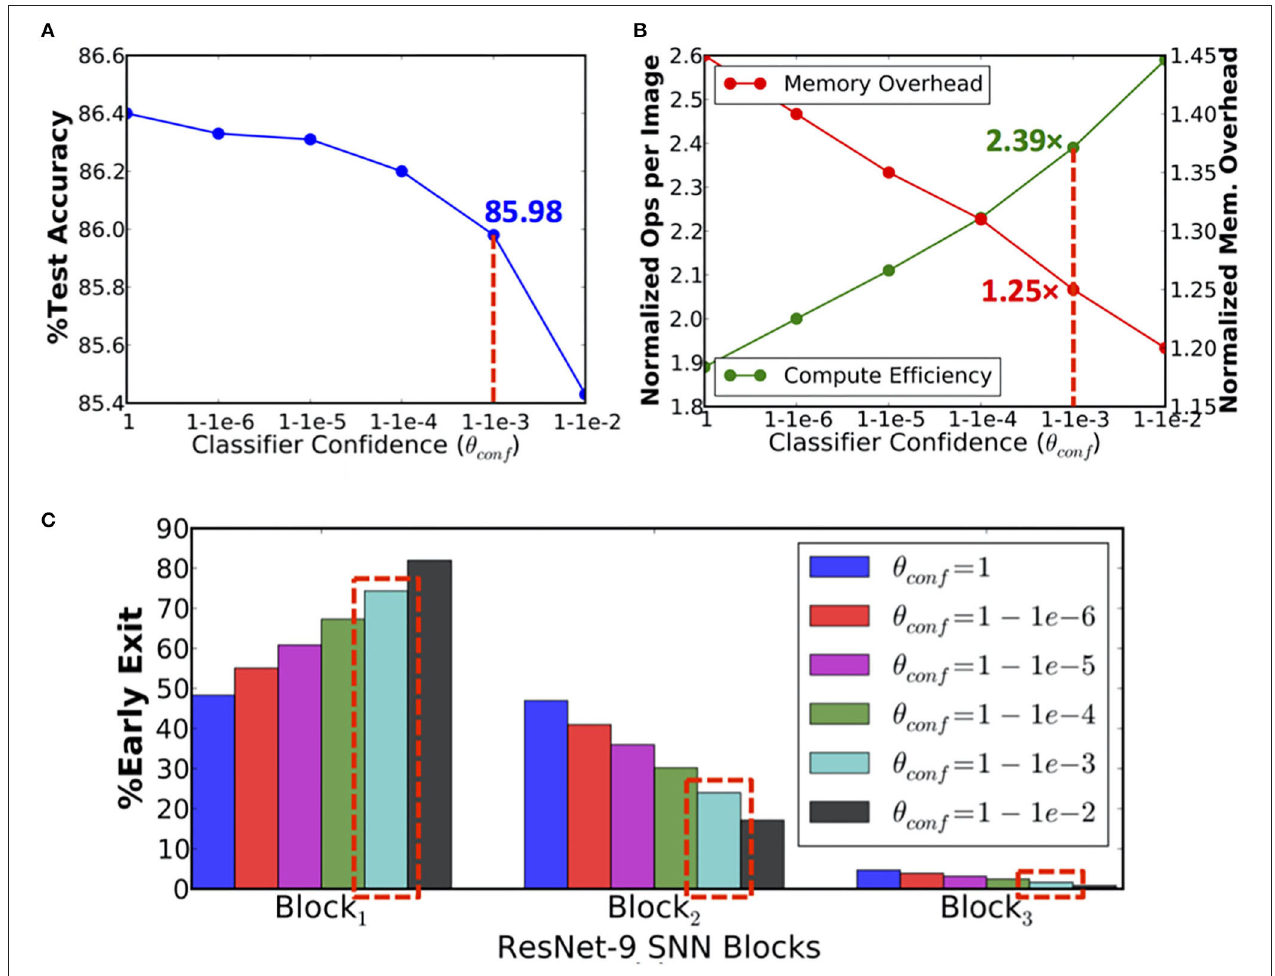
FIGURE 6 | (A) Test accuracy, (B) computational efficiency in terms of the normalized number of synaptic operations and memory overhead per inference, and (C) percentage of exiting inputs per block vs. classifier confidence thresholds ( θ conf ) for ResNet-9 spiking neural network (SNN) on